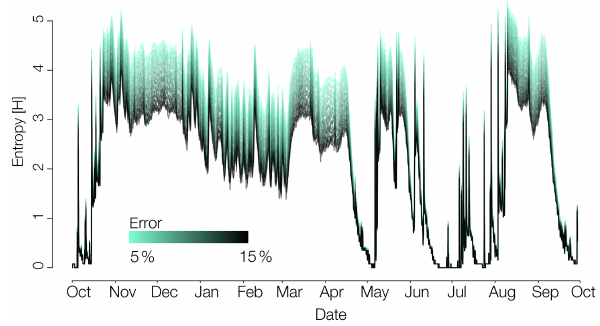
Figure B1. Influence of the bin